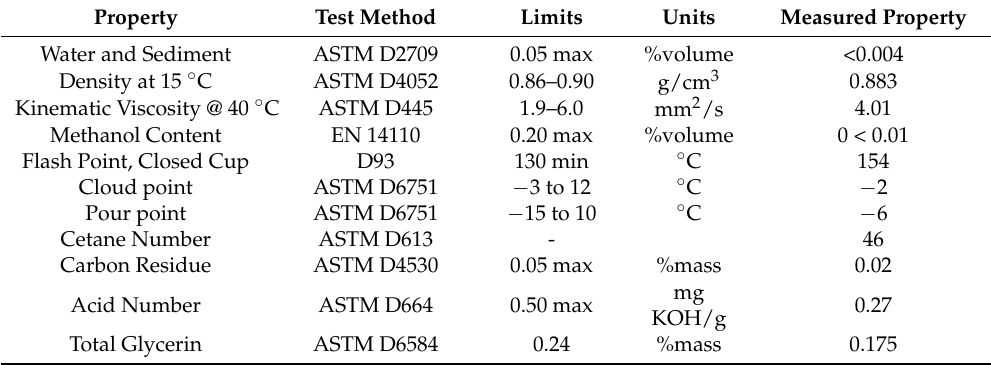
Table 8. The produced biodiesel properties in comparison with the ASTM D6751 standard.